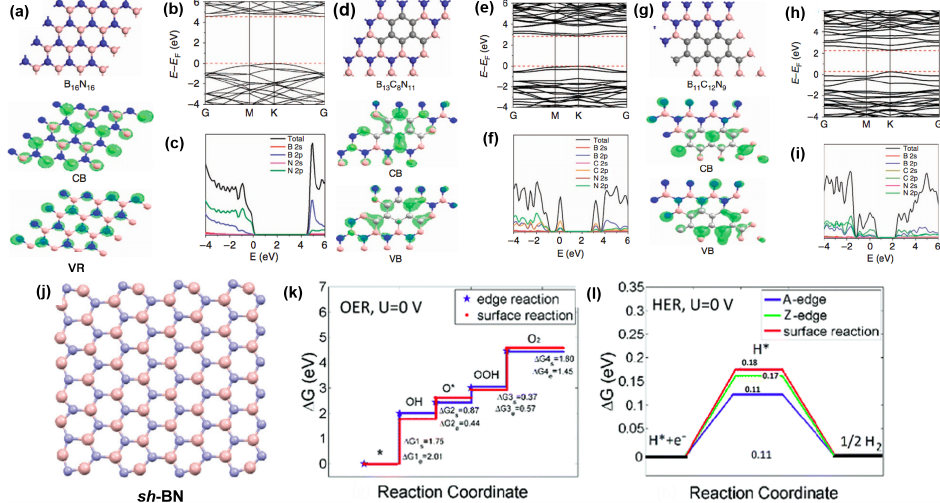
Figure 17. The optimized structures of h -BN and h -BCN with respect to ( a ) B 16 N 16 , ( d ) B 13 C 8 N 11 and ( g ) B 11 C 12 N 9 with the corresponding VBM and CBM, calculated energy band ( b , e , h ) and the corresponding total and projected electronic density of states ( c , f , i ). Reproduced with permission from reference [237]. Copyright 2015, Springer Nature. ( j ) The optimized structure of sh -BN monolayer and the free energy diagram of (j) the OER and ( k ) the HER for sh -BN monolayer. Reproduced with permission from reference [238]. Copyright 2020,